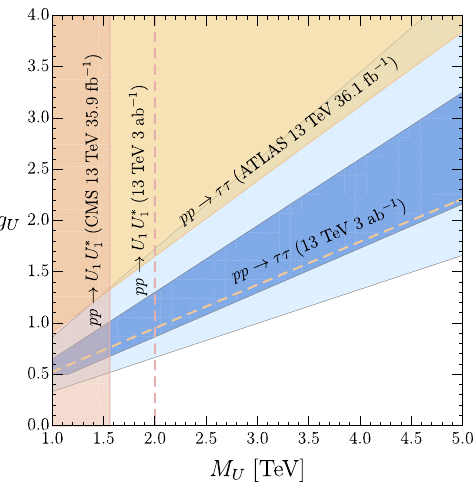
Figure 4 . High- p constraints on the SU(2) T 1 σ and 2 σ regions preferred by the low-energy fit are shown in blue and light blue,